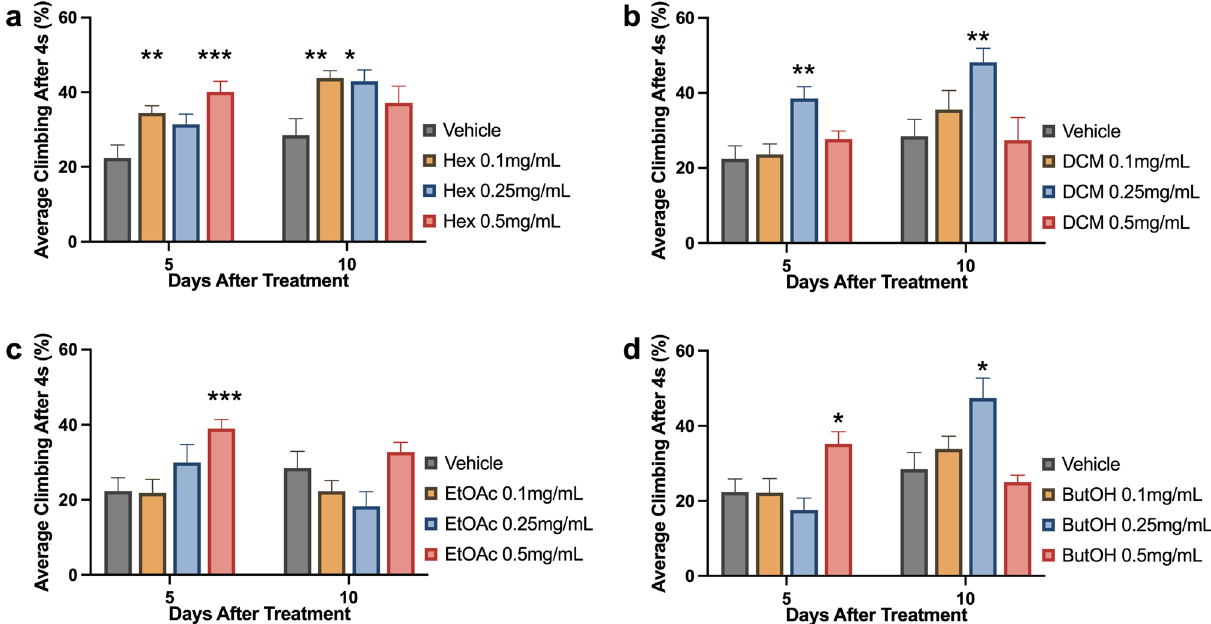
Figure 4. AD-like flies climbing ability after 5 and 10 days of treatment with Tween 0.01% (used as a vehicle) or either ( a ) hexane, ( b ) dichloromethane, ( c ) ethyl acetate or ( d ) n-butanol fractions at 0.1, 0.25 and 0.5 mg/ mL. Data are shown as the mean ± S.E.M. (n ≥ 90 in each treatment). The statistical significance is indicated as * indicates P < 0.05, ** P < 0.01 and *** P < 0.001 in comparison to vehicle treated flies (Unpaired two-tailed t-test).